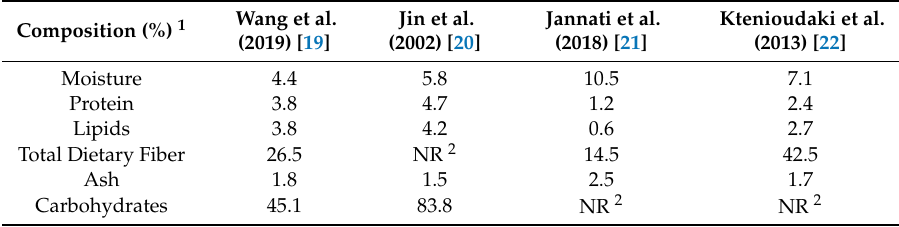
Table 2. Di ff erent physical–chemical compositions of apple